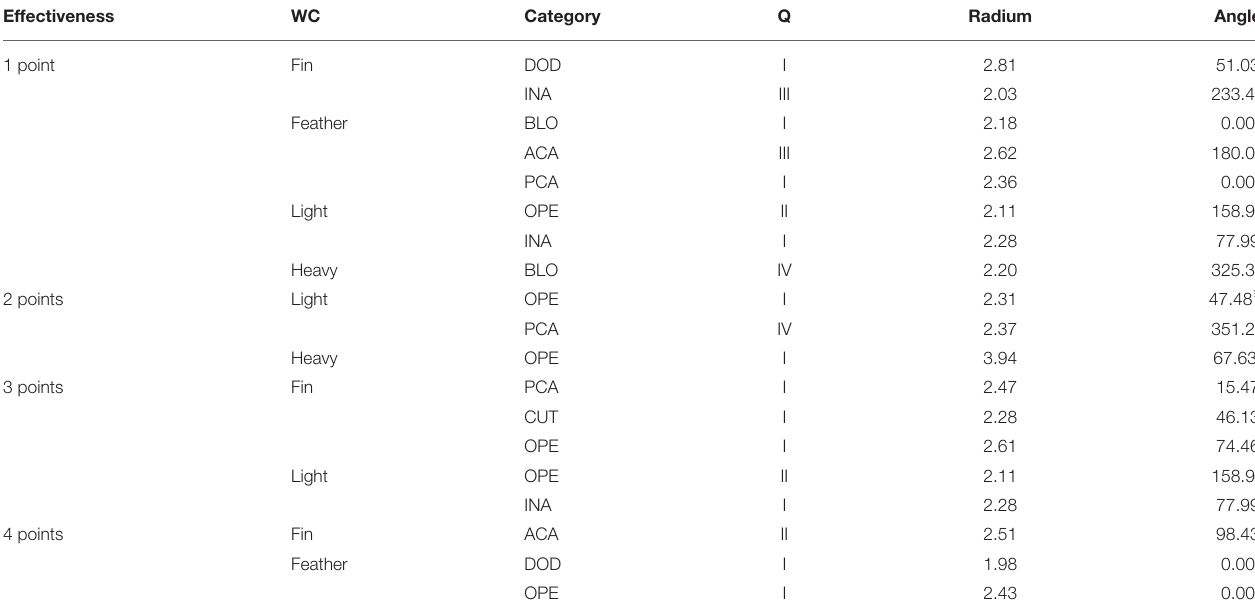
TABLE 3 | Polar coordinate significant patterns for effective actions in females. Effectiveness